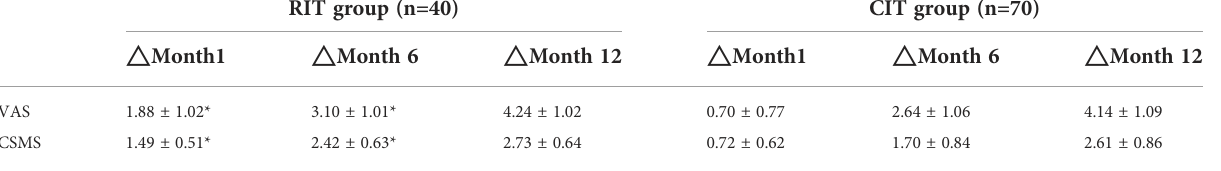
TABLE 4 VAS and CSMS improvements for patients in the RIT and CIT